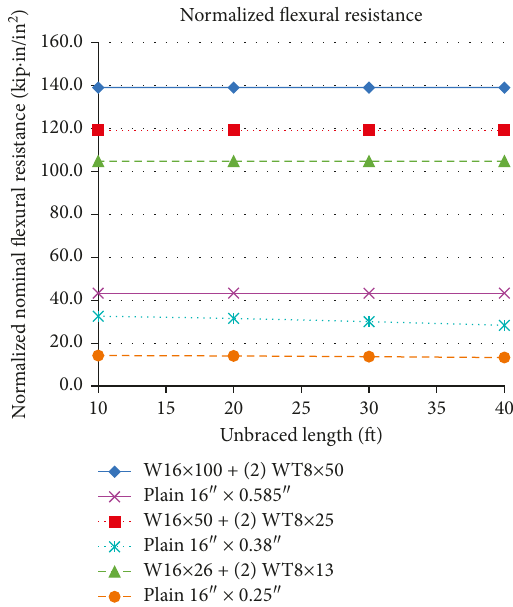
Figure 8: Normalized flexural resistance for comparative plain and flanged cruciform members (1 ft 0.305 m and 1 kip/in 2 6.895 (cid:30) (cid:30)